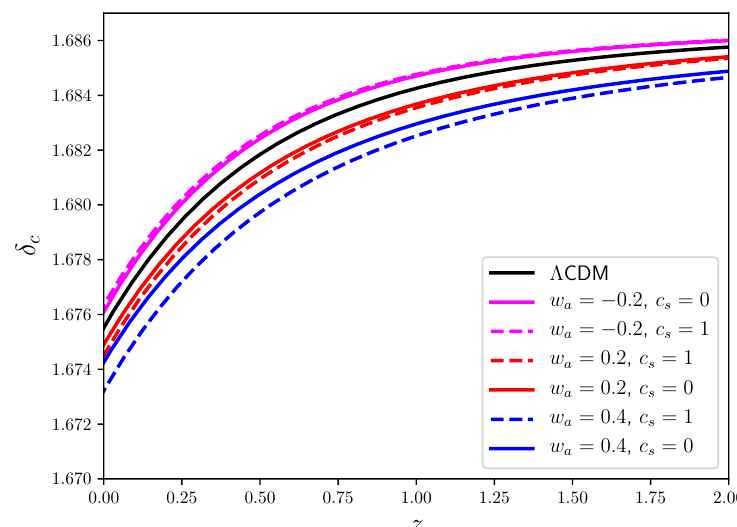
Figure 2. Collapse threshold as a function of redshift for various combinations of w a and c s indicted in the plot legend. For all models, we set w 0 = 1 and Ω m 0 = 0.3. As can be seen, the impact of w a − and CDE in this quantity is very small, below 1% for the examples shown in this